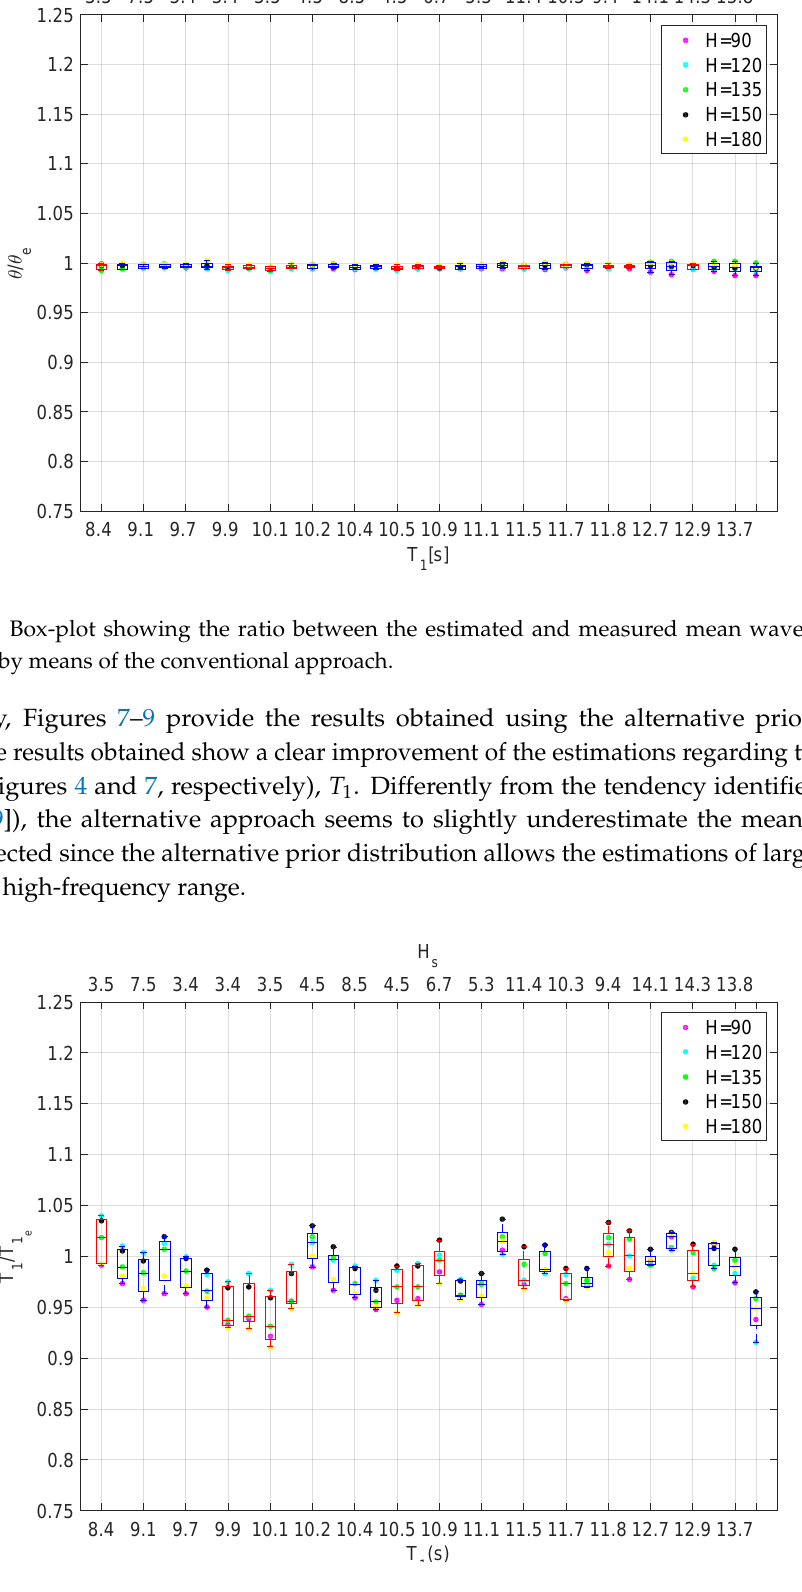
Figure 7. Box-plot showing the ratio between the estimated and measured mean wave period, obtained by means of the alternative prior